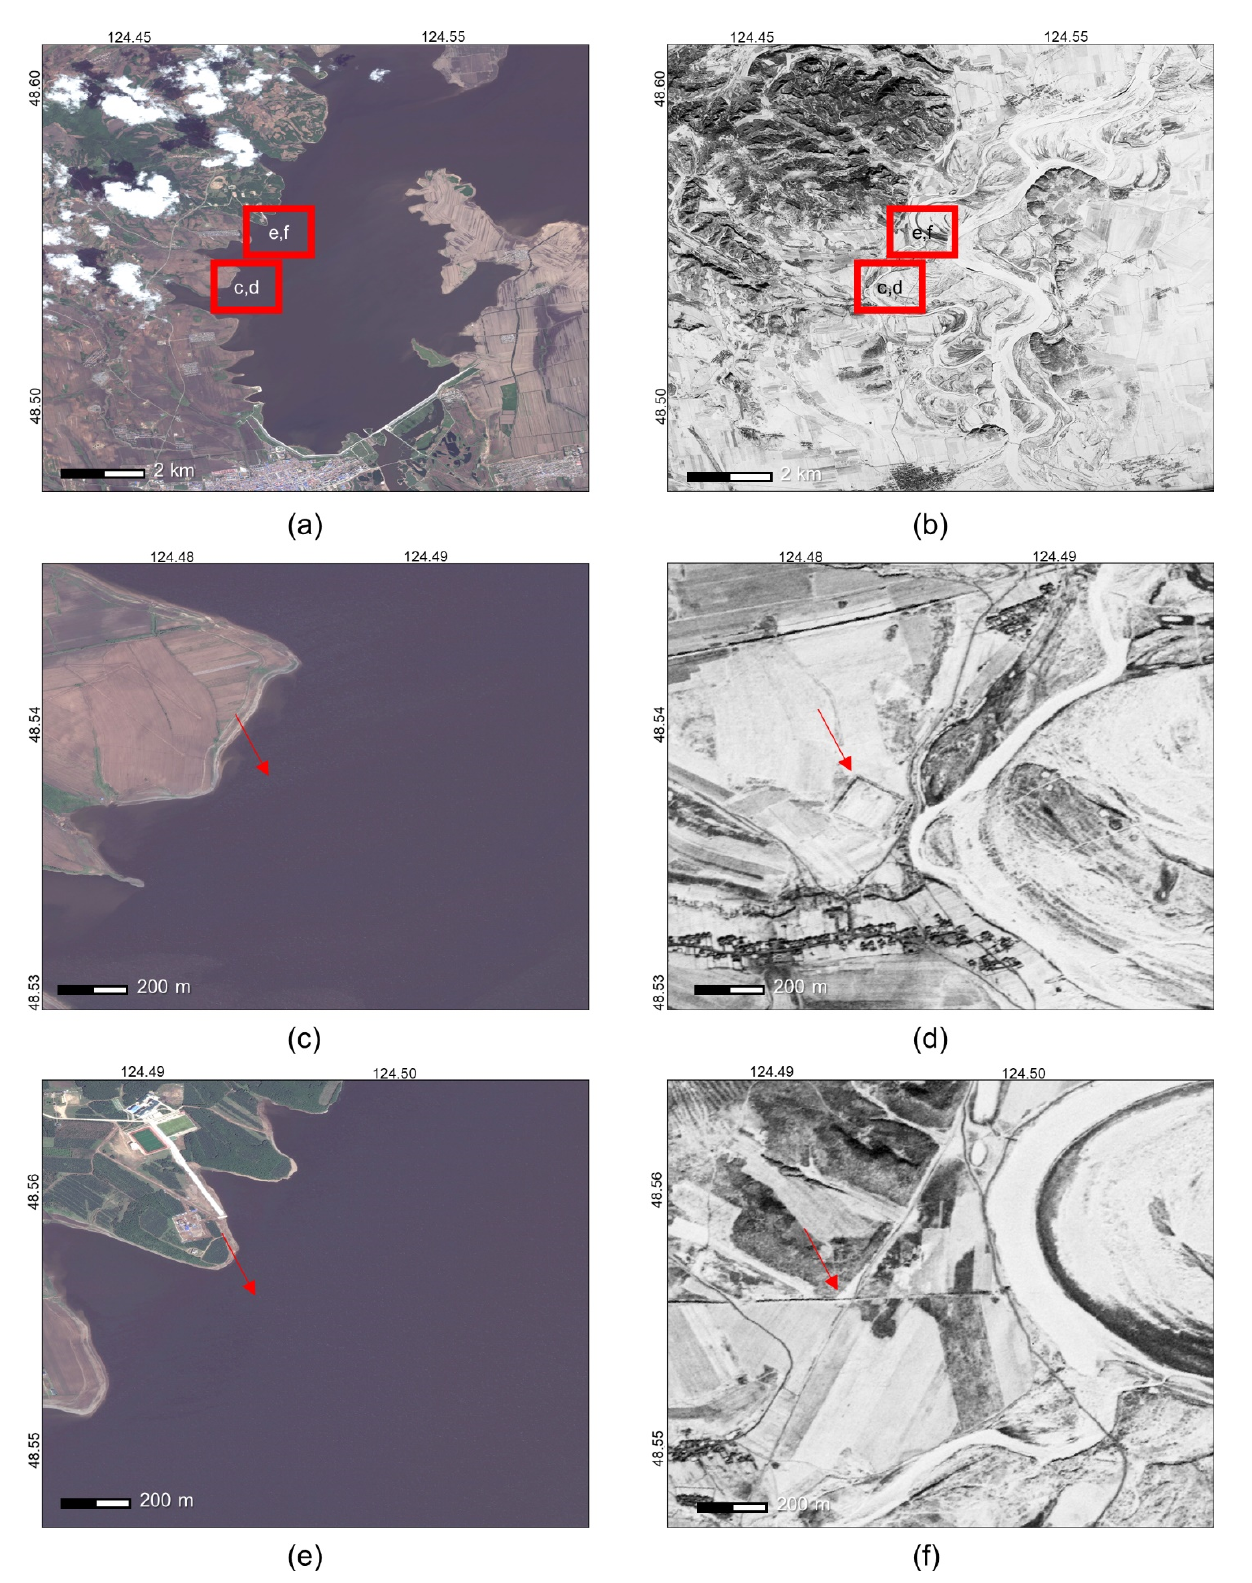
Figure 9. Forts destroyed by the Nierji Dam: ( a ) overview of dammed area, ( b ) image before dam construction, ( c ) dam construction, ( d ) fort on CORONA image before dam construction, ( e ) fort location on Bing Maps, ( f ) wall line on CORONA image.